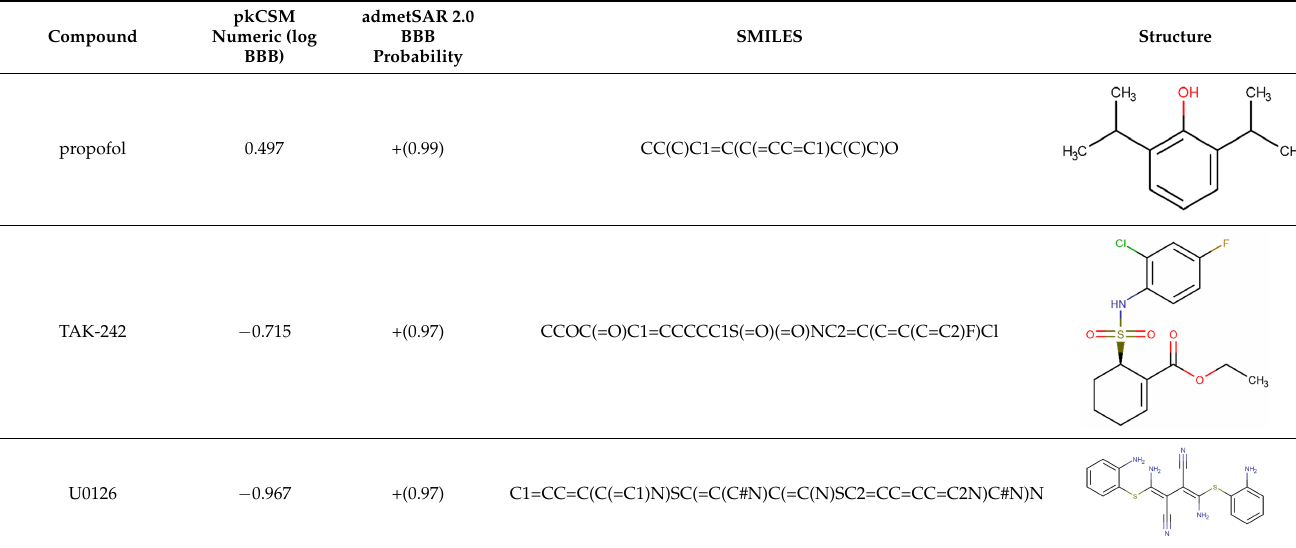
Table 2. Compound name, SMILES code, chemical 2D structure, pkCSM [189] (sourced from pkCSM-parmacokinetics server [191]) and admetSAR2.0 [190] (sourced from admetSAR web server [192]) predictions. Molecules with a logBB > 0.3 are believed to cross the BBB, whereas molecules with a logBB-1 are poorly dispersed to the brain, according to pkCSM. admetSAR2.0 estimates a probability, with 1 indicating that the molecules cross the BBB and 0 indicating that they do not.